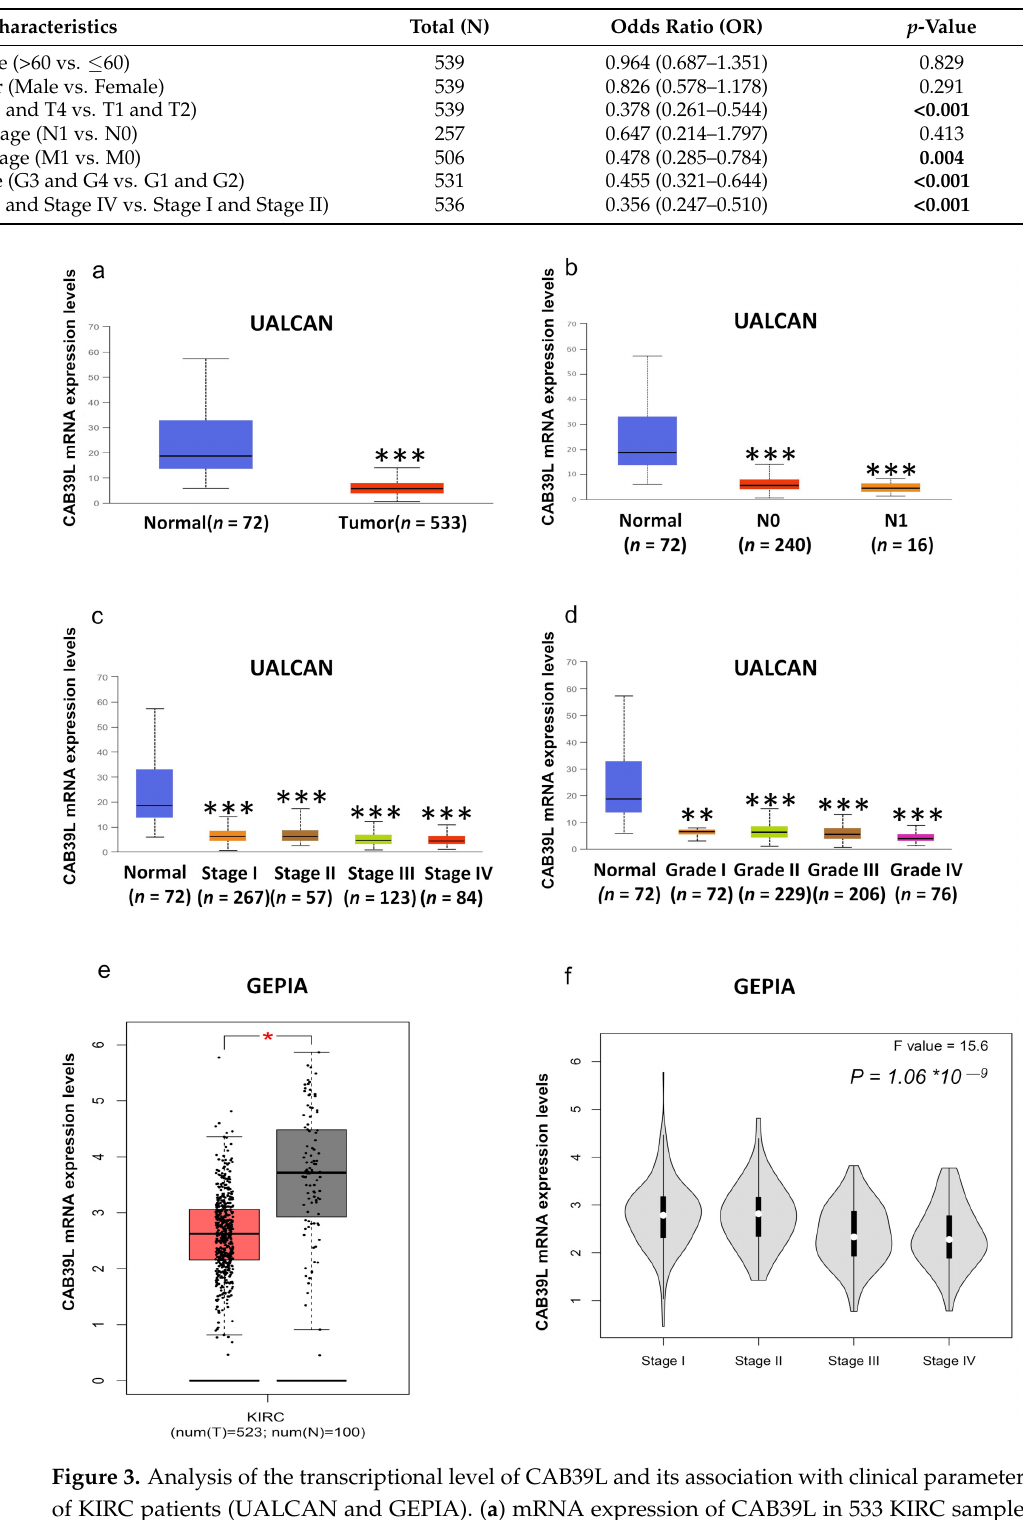
Table 2. Logistic analysis of the association between CAB39L mRNA expression and clinical charac- teristics of KIRC patients.